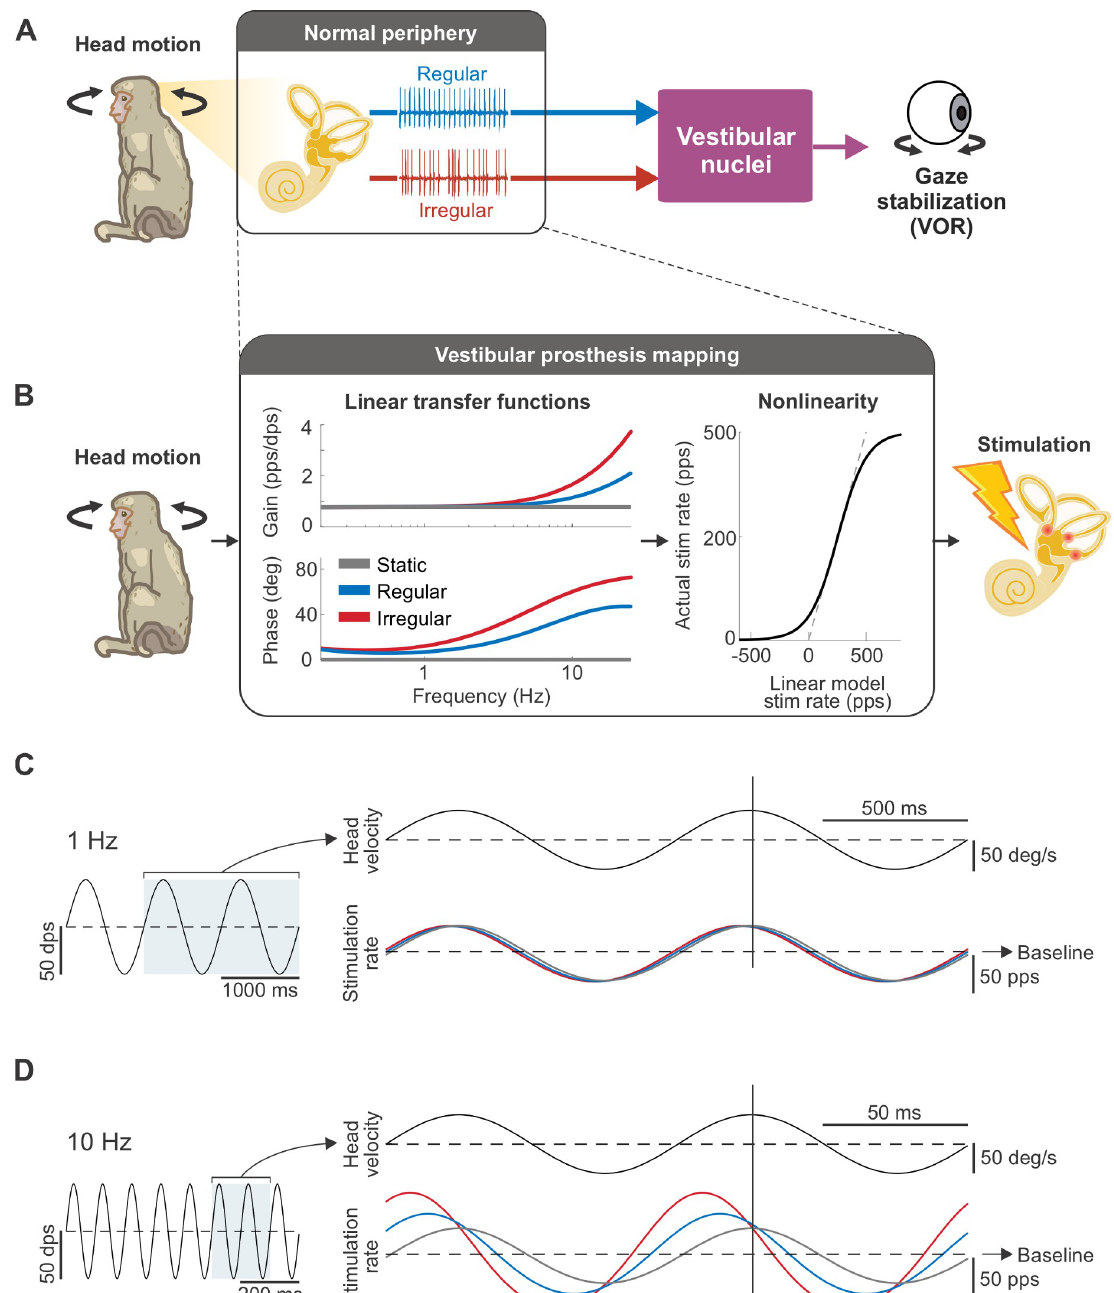
Fig 1. Biomimetic afferent response dynamics are implemented in the vestibular prosthesis mapping between head motion and stimulation rate. ( A ) Schematic of the VOR pathway. Both types of vestibular afferents (regular and irregular) convey head movement information to the vestibular nuclei, which, in turn, stabilize the gaze via the VOR. ( B ) Schematic of how the prosthesis converts head movements into pulsatile stimulation. The mapping (black box) consists of the linear transfer functions, which mimic the response dynamics of regular (blue) and irregular (red) afferents or represent the conventional mapping with static gain and phase lead (gray), in cascade with the sigmoidal nonlinearity, which limits the firing rate to be above zero and below the maximum rate of 500 Hz. ( C ) Example of the stimulation rate, modulated around the baseline rate of 150 pps, in response to sinusoidal head movements at 1 Hz. At this frequency, the stimulation rates are similar for all mappings. Vertical line denotes the peak of head movement for phase comparison. ( D ) Example of the stimulation rate in response to sinusoidal head movements at 10 Hz. Both regular and irregular mappings display greater depth of modulation in firing and bigger phase lead than the static mapping, which remains in-phase and shows the same depth of modulation as in